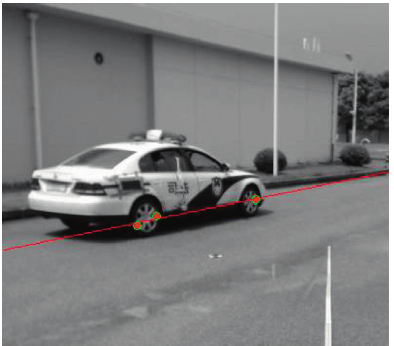
Figure 12: Difficult to ensure the selected feature points are on the same line.